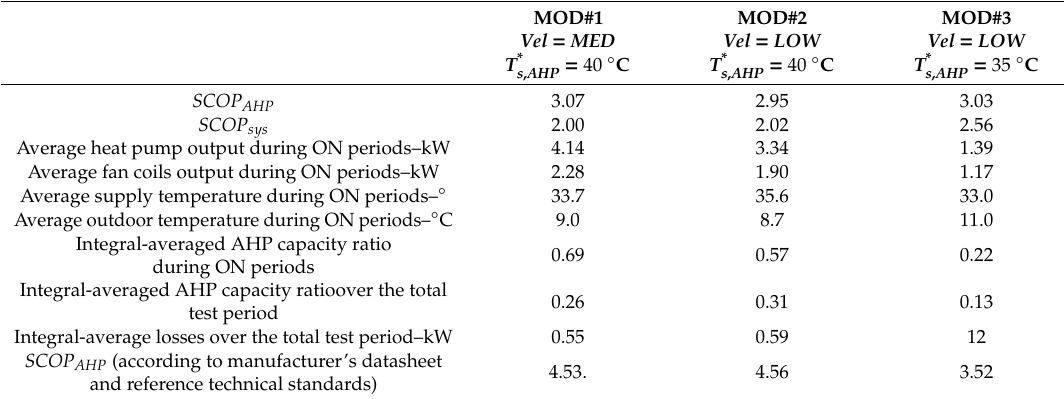
Figure 11. Detail of ON–OFF cycles under MOD#1. Table 5. Summary of AHP and Overall System